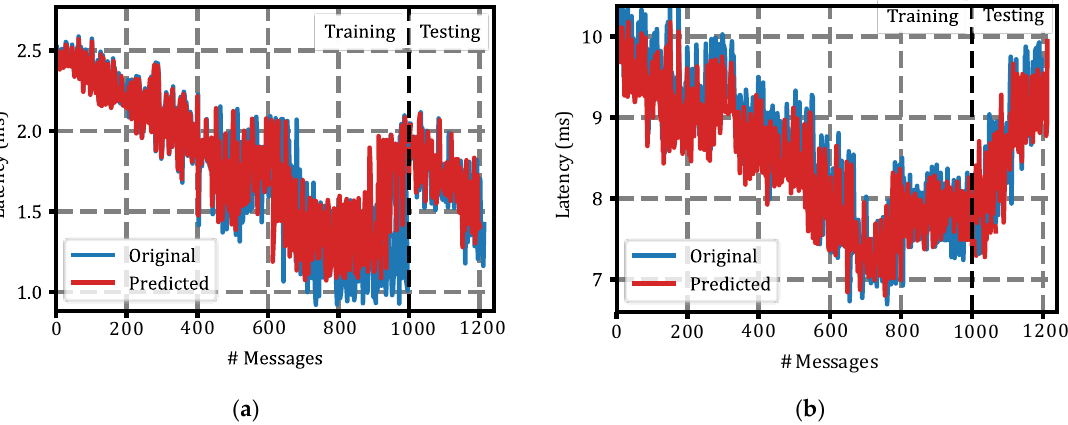
Figure 10. Latency behavior and split: ( a ) Latency temporary evolution for a random vehicle in each simulation group. The legend indicates the number of vehicles simulated simultaneously; ( b ) Example of dataset division. Up to latency sample (message), 1000 was used to form the training dataset, blue line. From the latency sample (message), 1000 was used for the test dataset, red line.